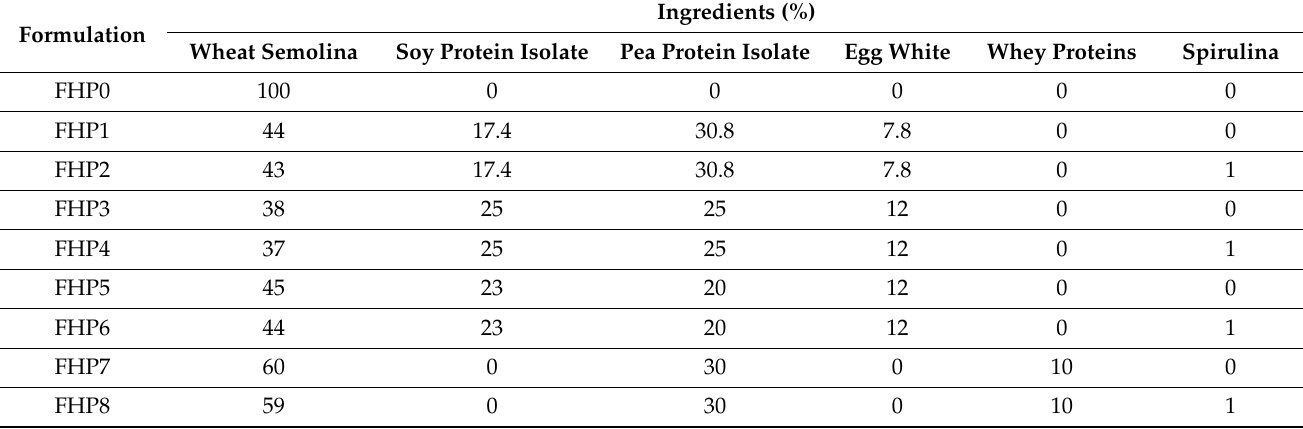
Table 6. Hypothesized high-protein pasta formulations (FHP).